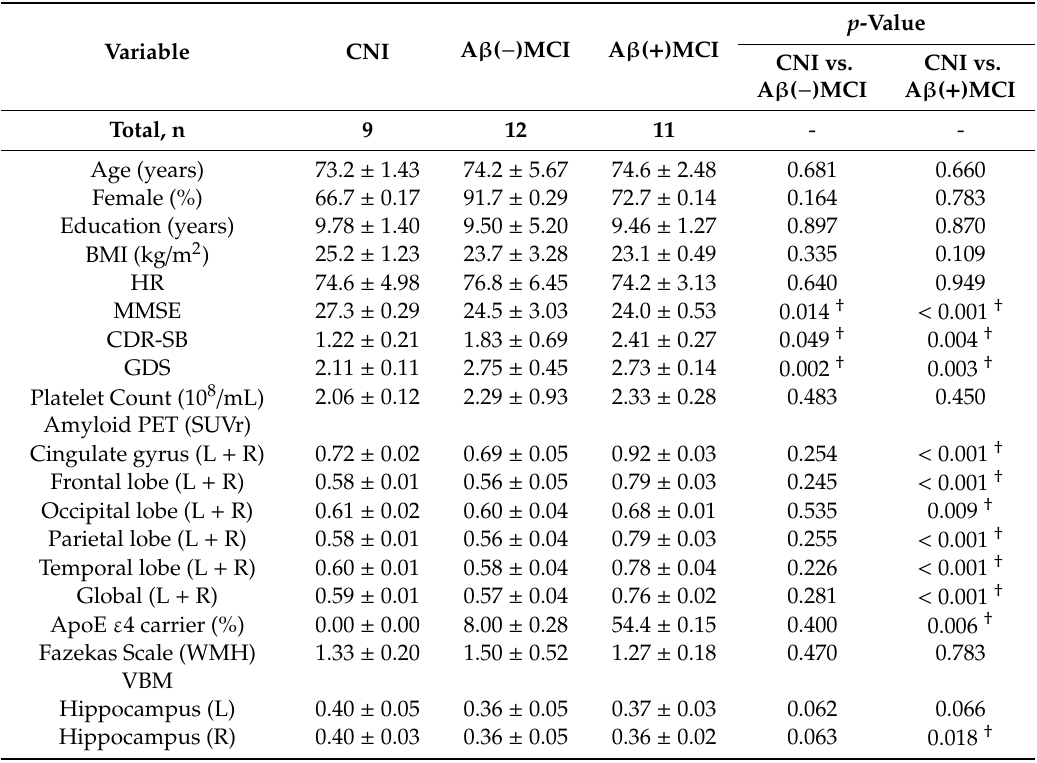
Table 1. Demographic and clinical characteristics of patients with A β ( − )MCI and A β ( + )MCI.